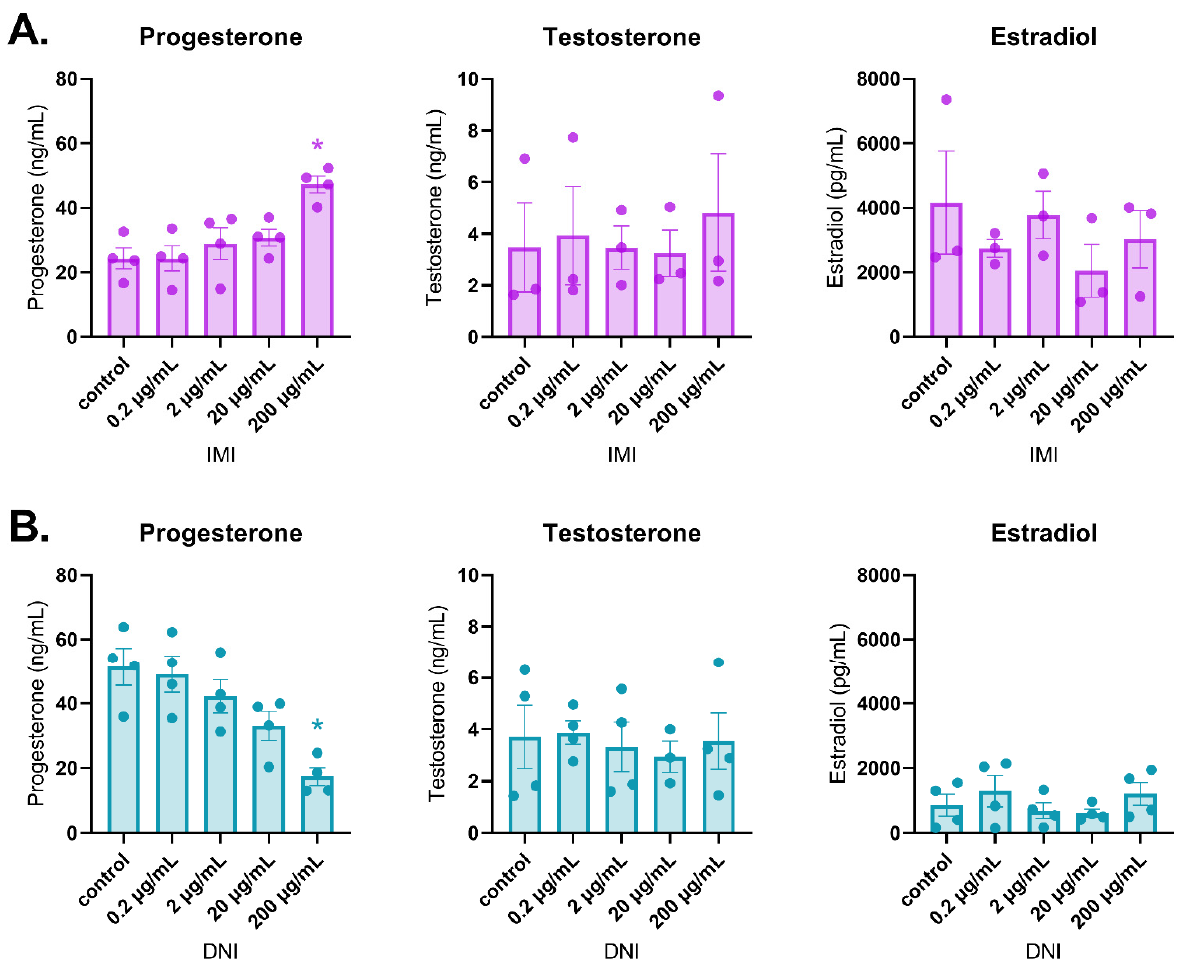
Figure 4. Effects of IMI ( A ) and DNI ( B ) on follicular sex steroid hormone levels after 72 h in culture. Antral follicles were treated with a vehicle (DMSO or water), IMI, or DNI (0.2–200 µg/mL) for 72 h. After the culture period, media from each treatment were pooled and subjected to ELISAS for testosterone, progesterone, and estradiol. The graphs indicate means ± SEMs from 3–5 separate cultures (8–12 follicles per treatment per culture). * p ≤ 0.05.